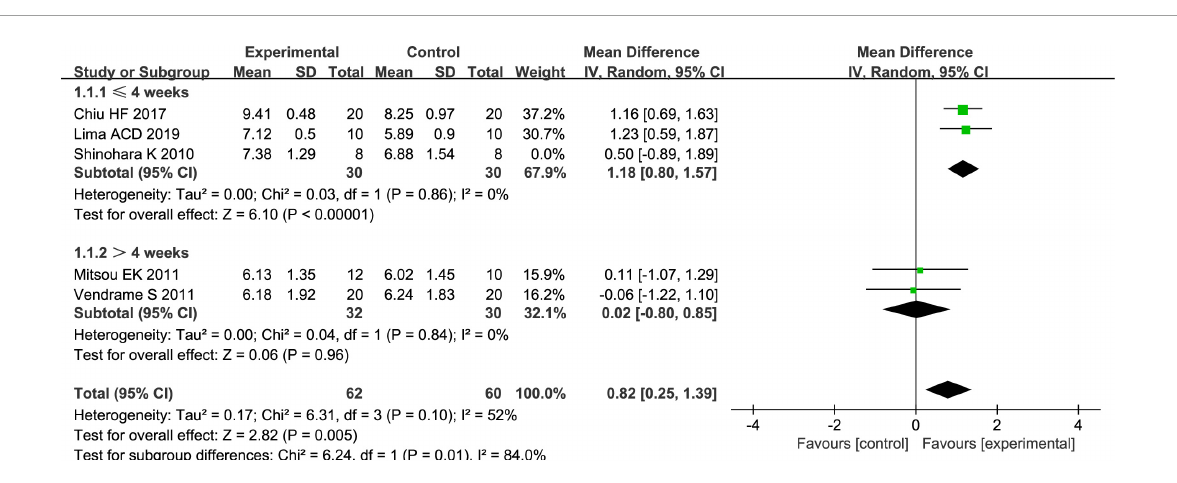
FIGURE9 Intervention effect of different fruits vs. placebo for L. acidophilus on patients in subgroup meta-analysis by different intervention